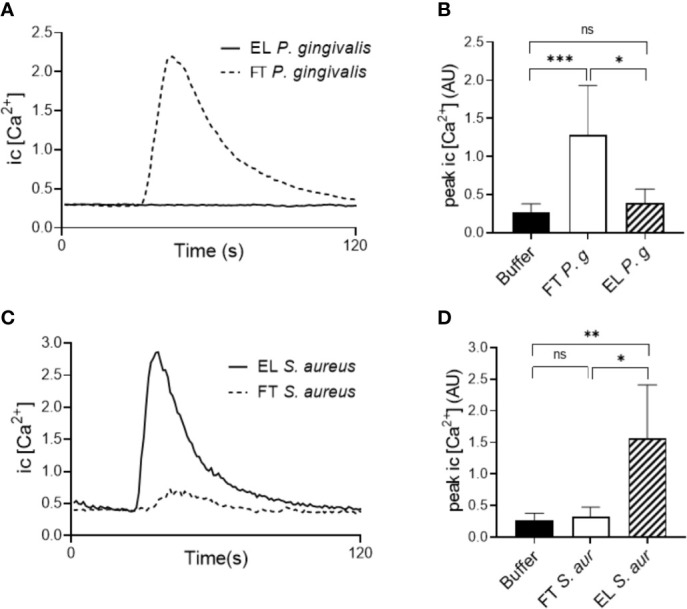
Biochemical separation of bacterial supernatants. The components of supernatants of P. gingivalis 381 and S. aureus were purified by C18 cartridge sorting to separate hydrophobic (Eluate (EL)) and hydrophilic (Flow through (FT)) molecules. Human buffy-coat neutrophils were stimulated with the EL and FT fractions of either culture supernatants and intracellular Ca2+ concentration was measured by flow cytometry. (A) Graph shows the neutrophil intracellular Ca2+ concentration after stimulation with the P. gingivalis 381 EL- and FT fractions from one representative experiment. (B) Peak values of neutrophil Ca2+ signals after P. gingivalis 381 EL- and FT fraction stimulation (mean + SD, n = 8). (C) Graph shows the neutrophil intracellular Ca2+ concentration after stimulation with the S. aureus EL- and FT fractions from one representative experiment. (D) Peak values of neutrophil Ca2+ signals after S. aureus EL- and FT fraction stimulation (mean + SD, n = 6). Kruskal-Wallis test followed by Dunn´s multiple comparison test was used for statistical analysis. ns >0.05, *<0.05, **< 0.01, ***< 0.001.